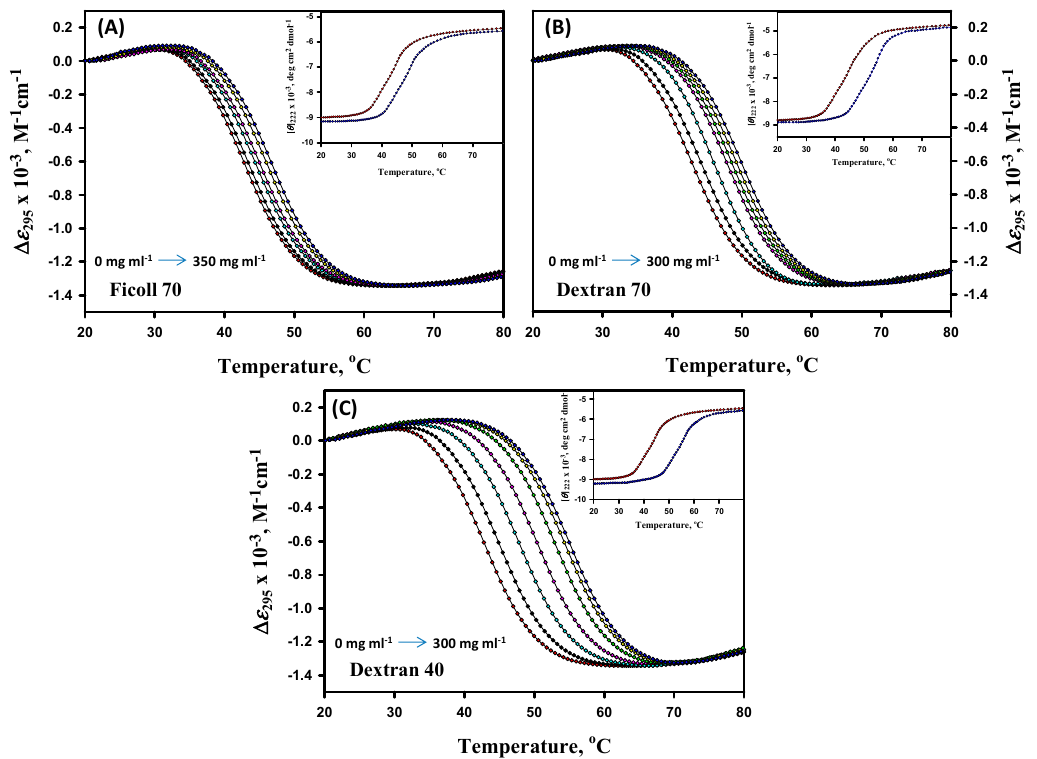
Figure 1. Thermal denaturation profiles of α -LA in the absence and presence of different concentrations of ficoll 70, dextran 70, and dextran 40 at pH 7.0 (panels A – C ). Different concentrations of all the crowding agents are represented by different colors: 0 mg mL − 1 (red), 50 mg mL − 1 (black), 100 mg mL − 1 (cyan), 150 mg mL − 1 (pink), 200 mg mL − 1 (green), 250 mg mL − 1 (yellow) and 300 mg mL − 1 (blue) (350 mg mL − 1 in the case of ficoll 70). For the sake of clarity, curves at all concentrations are not shown. Insets in all the panels represent thermal denaturation profiles of α -LA measured by [ θ ] 222 in the absence (red circle) and the presence of the highest concentration of the crowder (blue circle).